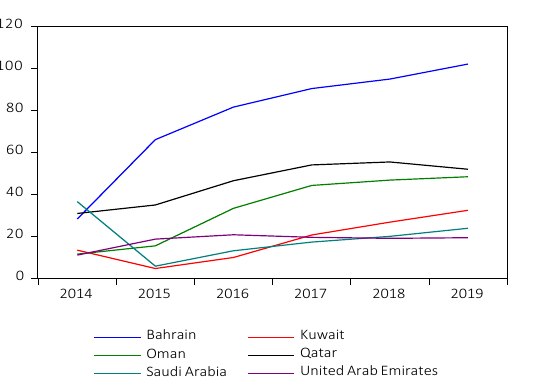
Figure 4. Graphical plot of economic multi-variables of the GCC